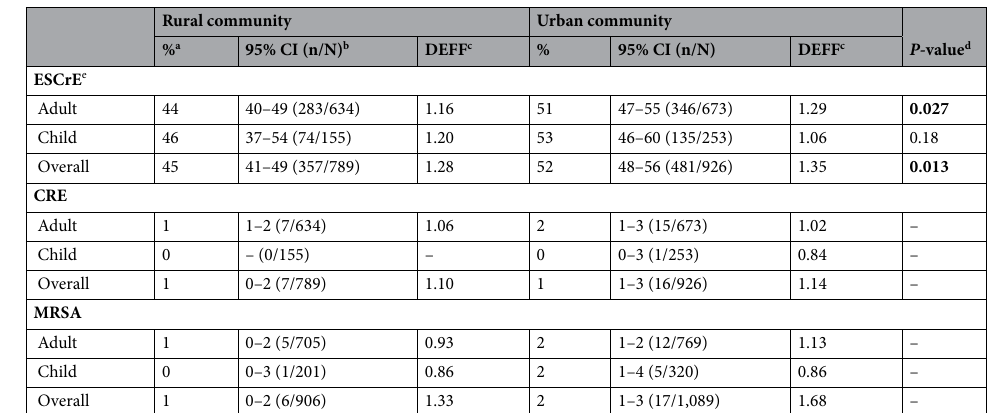
Table 1. Prevalence of colonization with antimicrobial-resistant bacteria in rural and urban communities, Kenya. Prevalence estimates, confidence intervals and statistical tests account for multi-stage cluster sampling design. a Prevalence is calculated on a per person level. “–” value not calculated due to limited sample size. b CI = confidence interval (n is the number of individuals colonized with ESCrE, CRE or MRSA bacteria, and N is the total number of people sampled). c DEFF = design effect, which is the ratio of the variance of the prevalence estimate when accounting for sampling design effects to the variance of the prevalence estimate assuming a simple random design. If DEFF = 1.0, there is no design effect. d P -value for rural versus urban comparisons. e ESCrE = extended-spectrum cephalosporin-resistant Enterobacteriaceae; CRE = carbapenem- resistant Enterobacteriaceae; MRSA = Methicillin-resistant Staphylococcus aureus . Significant values are in